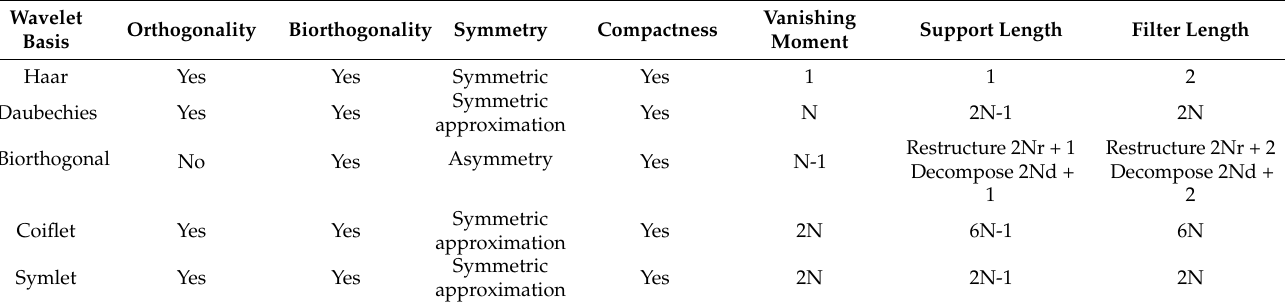
Table 1. Parameter characteristics of wavelet basis functions.